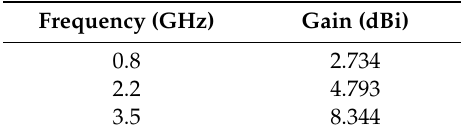
Figure 10. Final antenna radiation pattern; ( a ) plane E and plane H at 800 MHz; ( b ) plane E and plane H at 2.2 GHz; ( c ) plane E and plane H at 3.5 GHz. Table 4. Gain (dBi) for the antenna obtained in the three-frequency bands optimization case.